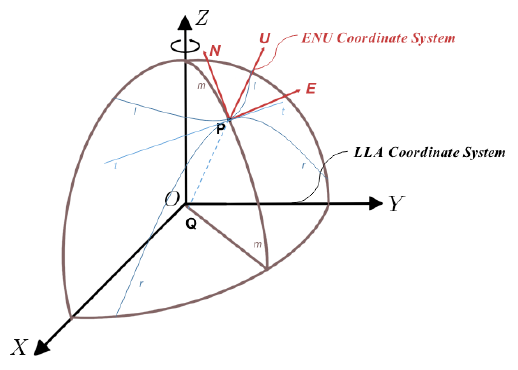
Figure 4. Relative position relationship between two coordinate systems.